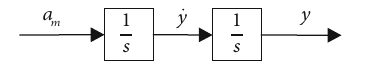
Figure 2: Dynamic model after